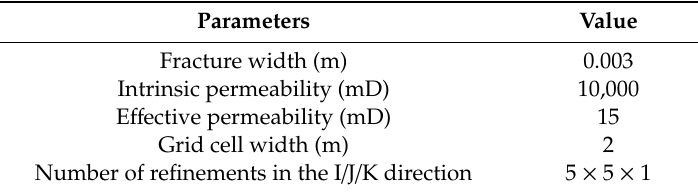
Table 4. Parameters for the Log Grid Refinement (LGR) method.